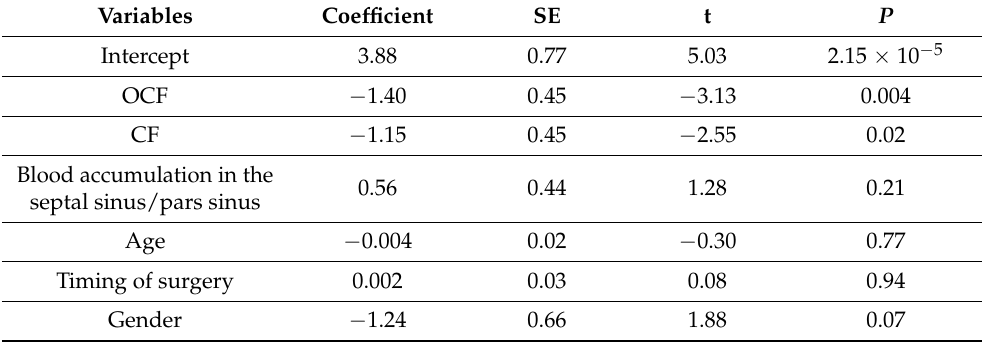
Table 4. Multiple linear regression analysis of IDVA in patients with TON.